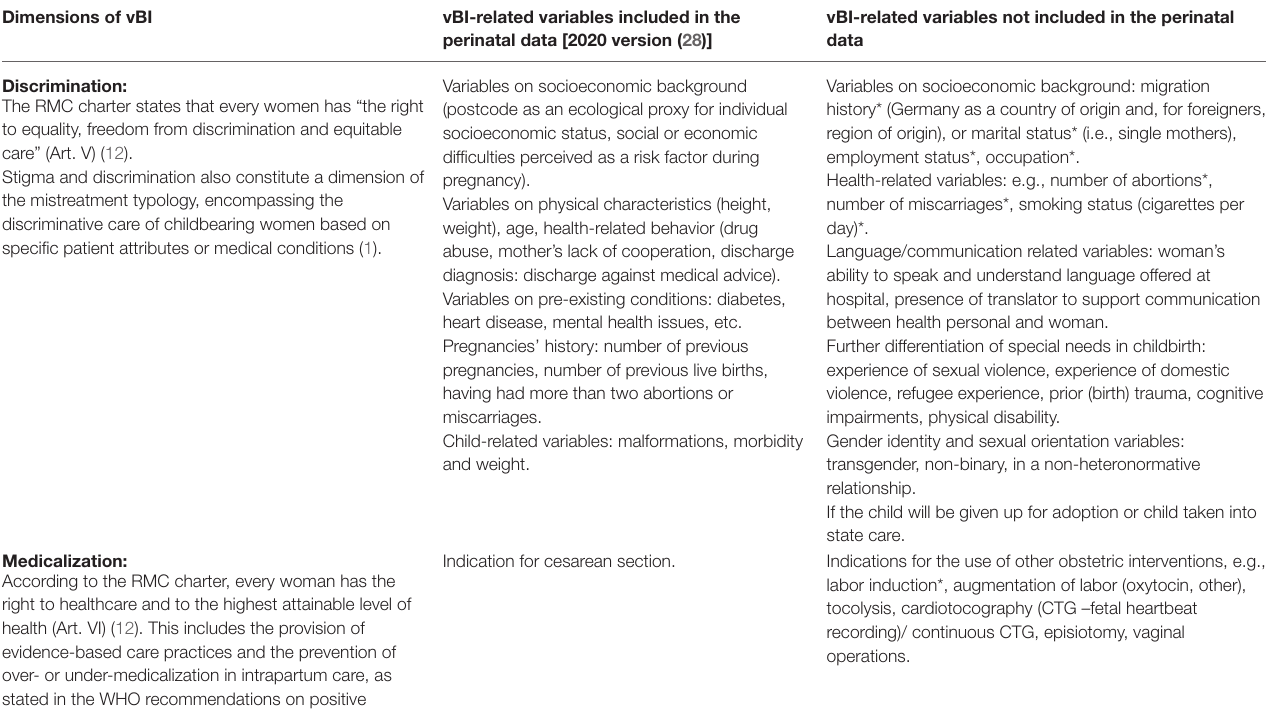
TABLE 1 | Dimensions of vBI and corresponding vBI-related variables of interest that are included in, or missing from, the perinatal data. Dimensions of